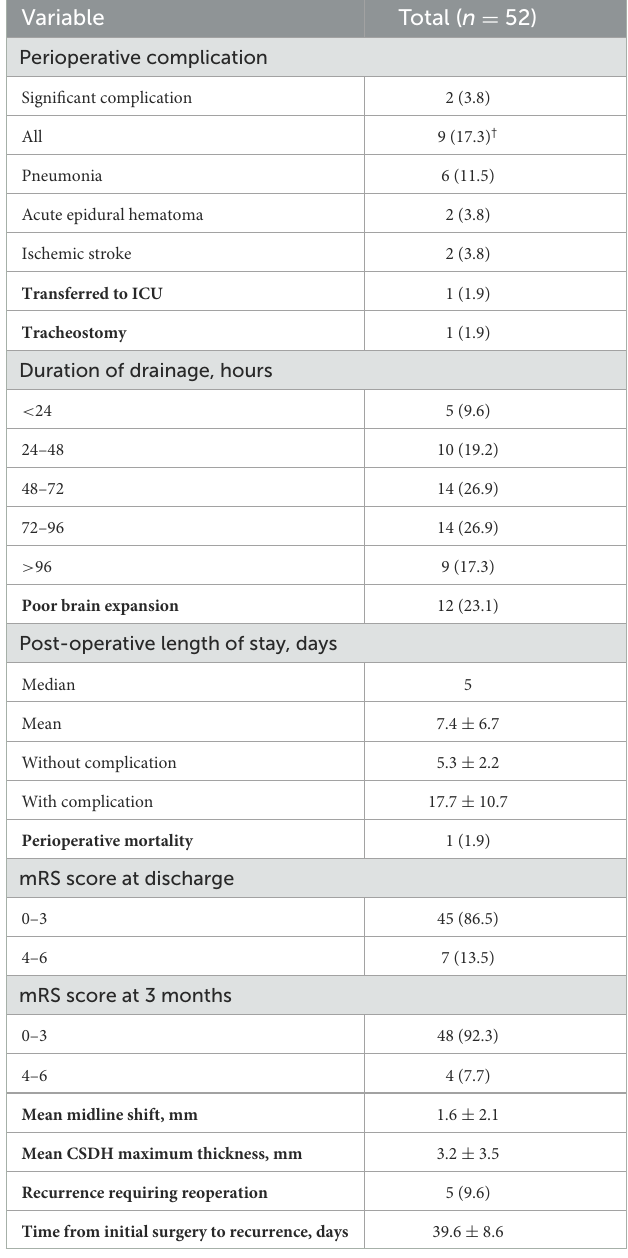
TABLE 2 Results of 52 very elderly patients treated by